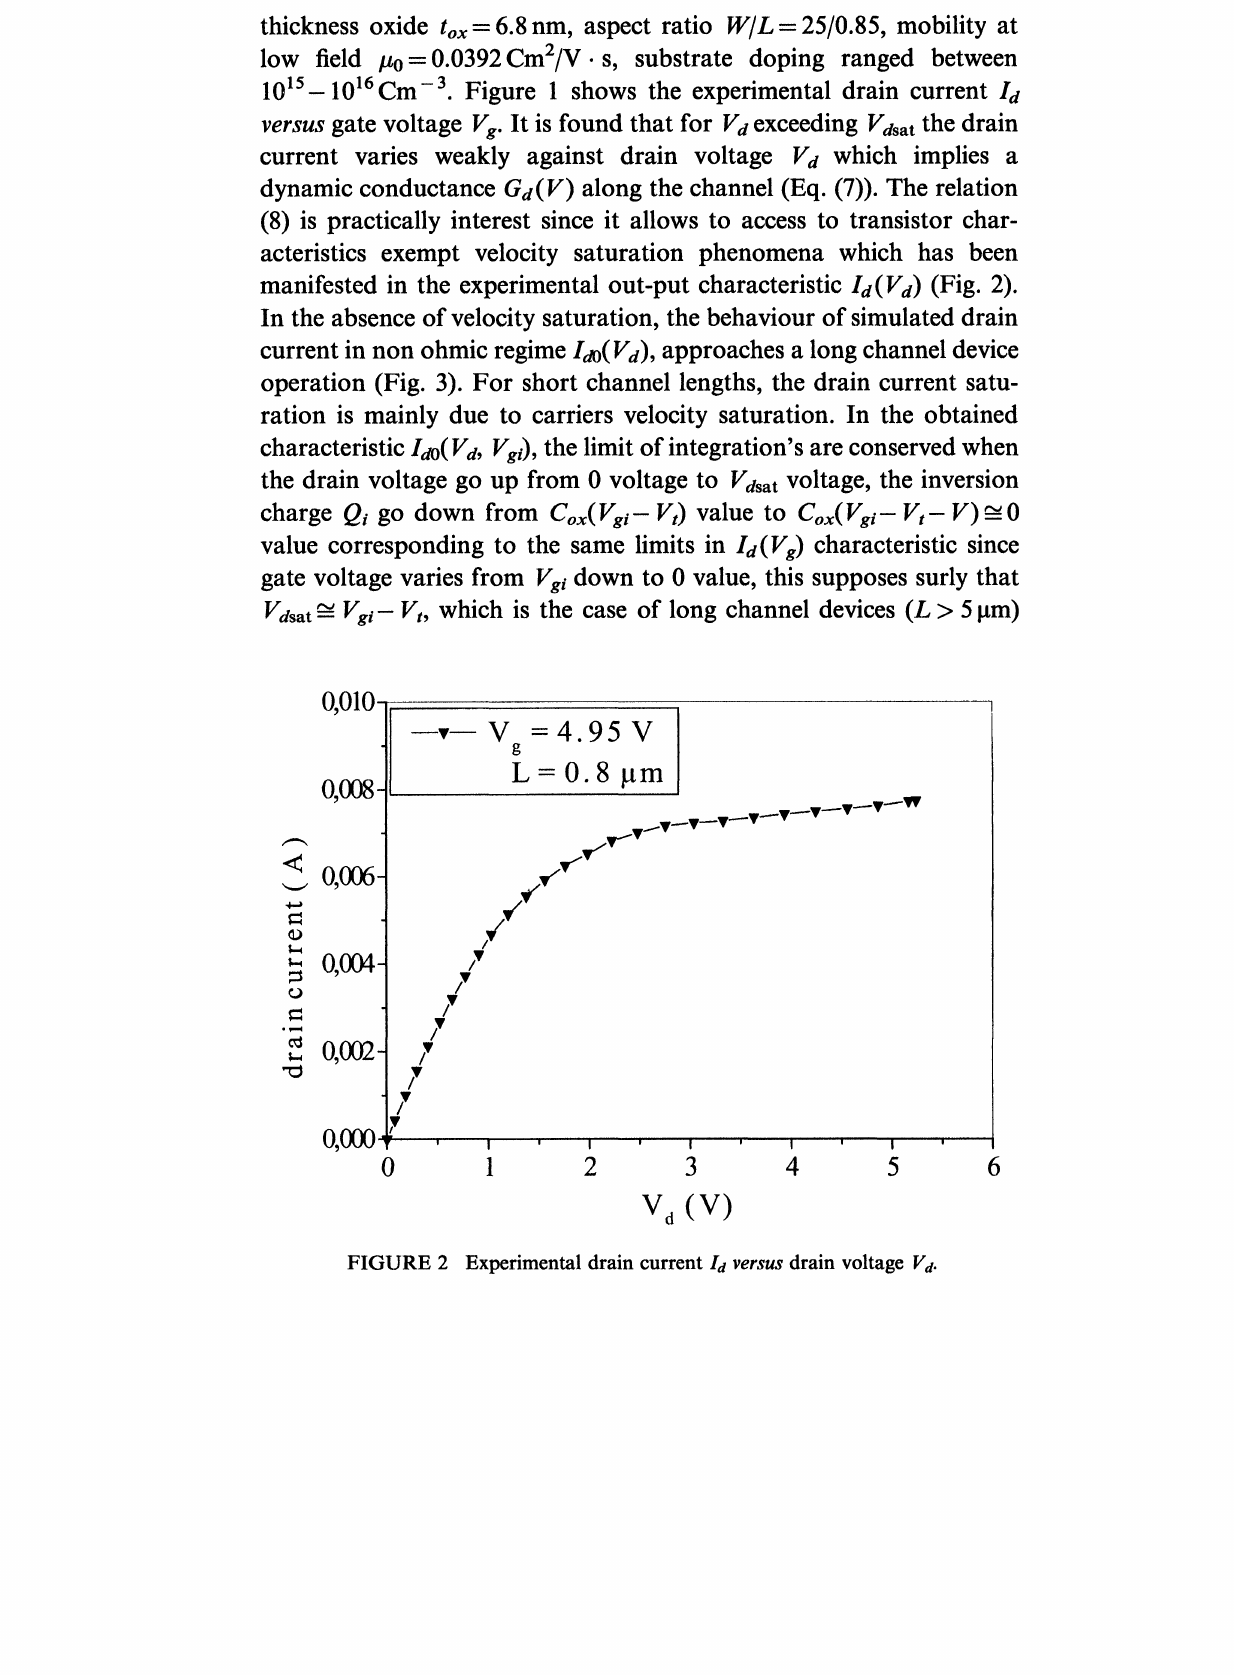
FIGURE 2 Experimental drain current Ia versus drain voltage